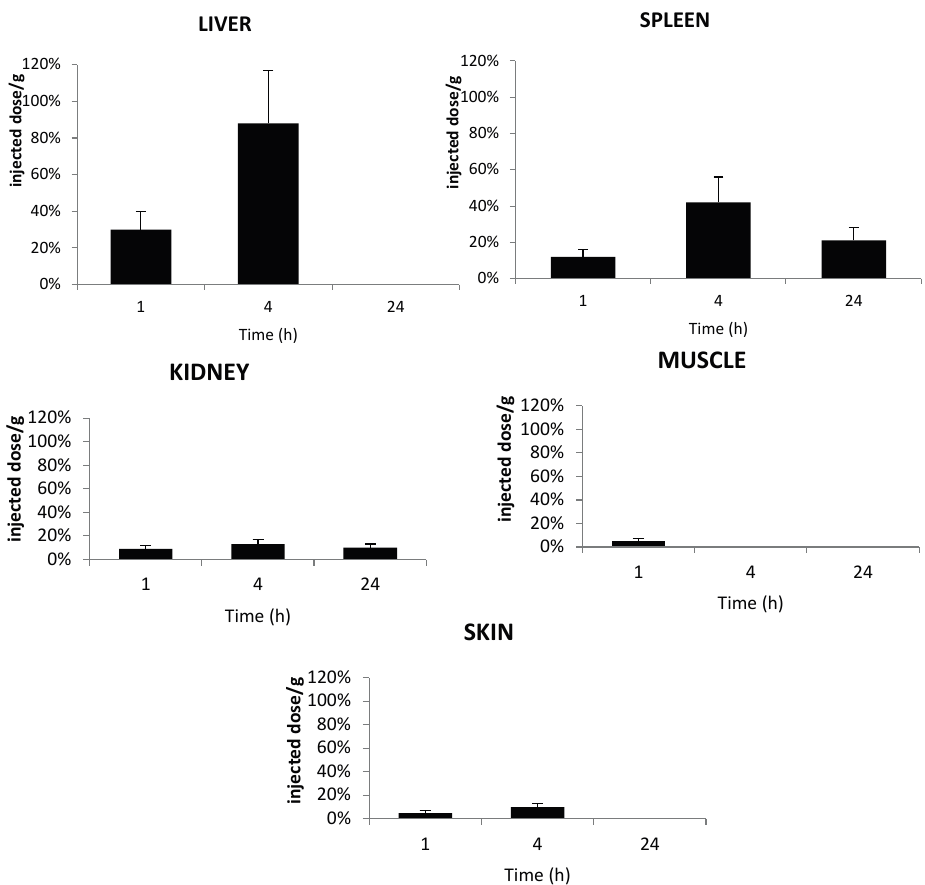
Figure 9. In vivo concentrations of TPC–PEG18–TKPRR in the liver, kidneys, spleen, muscle and skin of healthy mice. Concentrations were determined by HPLC analysis of the tested tissues and expressed as the percentage of injected dose per gram plasma, expressed as a function of time at one, four and 24 h after the intravenous injection of 2.8 mg/kg (data points show the mean ± S.D., n ≥ 3).